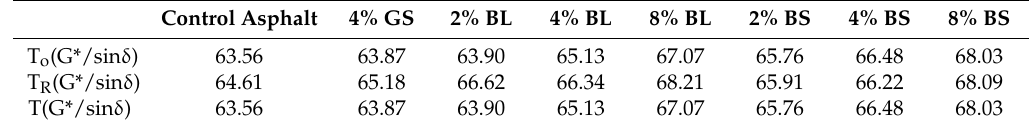
Table 3. The high critical temperatures of control, graphite modified, and bio-char modified asphalts.